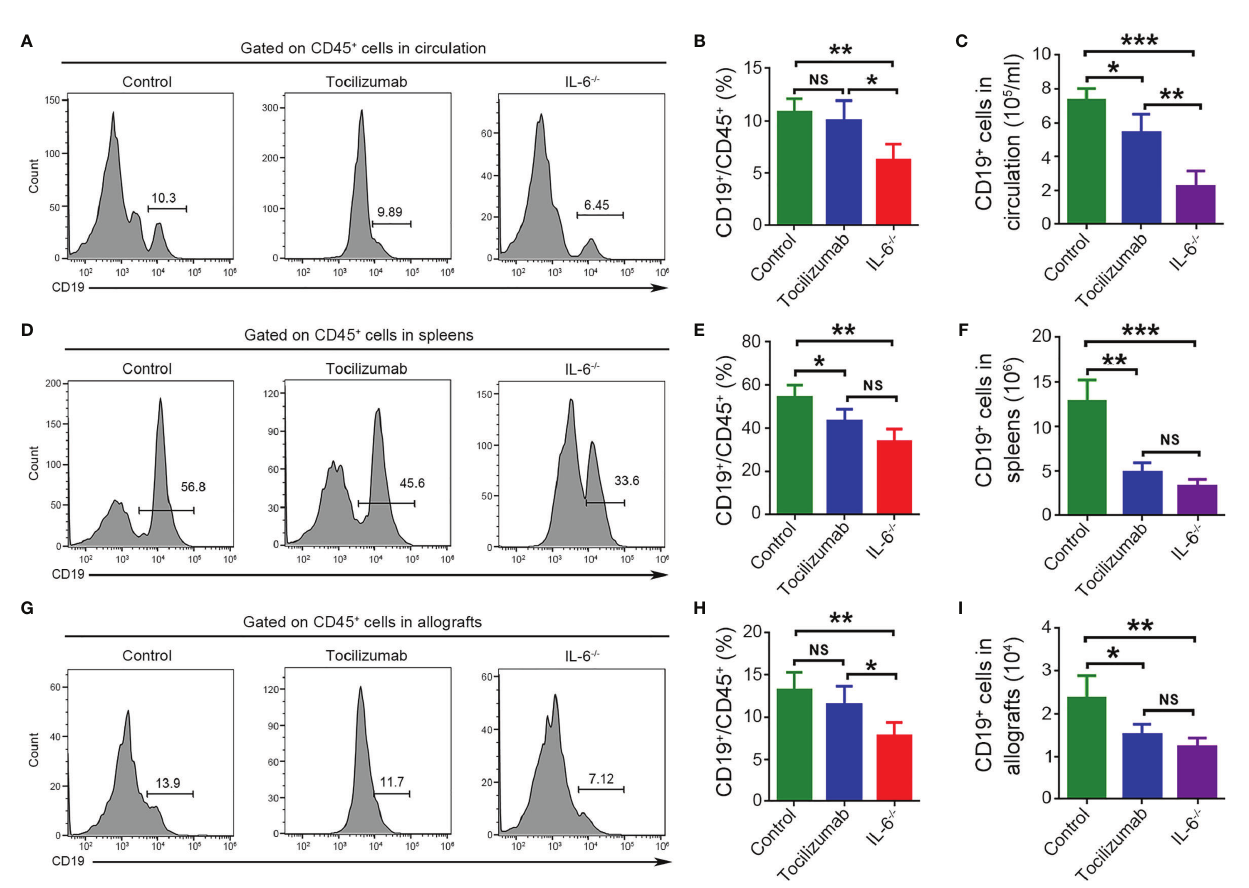
FIGURE 4 | Blockade of IL-6/IL-6R signaling reduces B cells. B cells (CD19 + ) were detected by fl ow cytometry 4 d after cardiac transplantation in the control, tocilizumab, and IL-6 -/- groups. Representative dot plots for frequencies and quantitative analysis of frequencies and counts of B cells in circulation (A – C) , spleens (D – F) , and cardiac allografts (G – I) (n = 4/group). *P<0.05; **P<0.01; ***P<0.001; NS, no signi fi